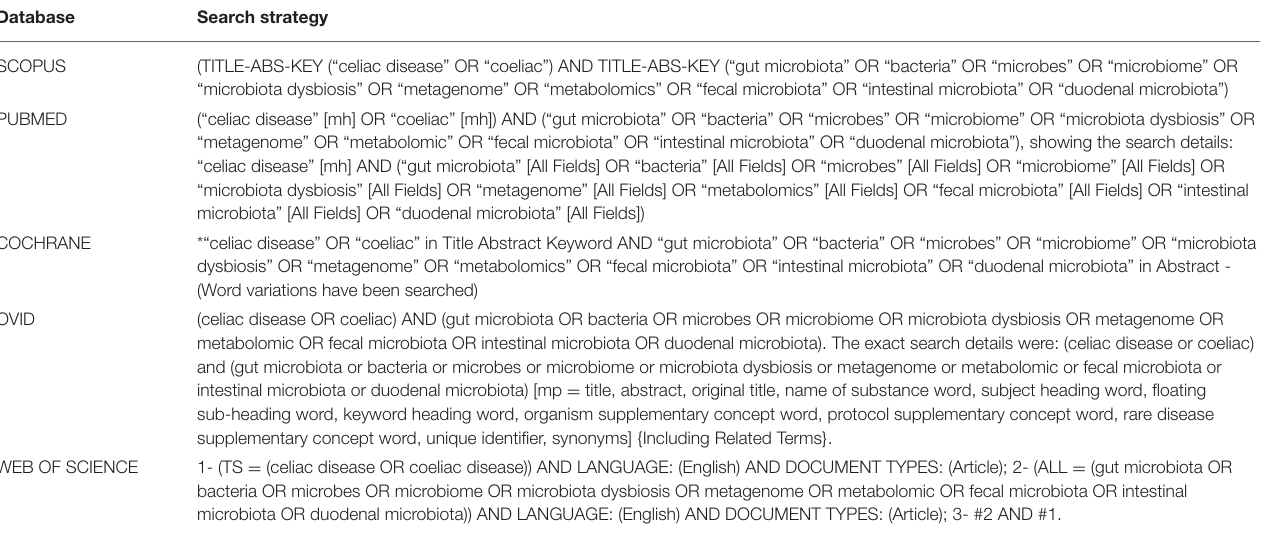
TABLE 1 | Search strategy of the systematic